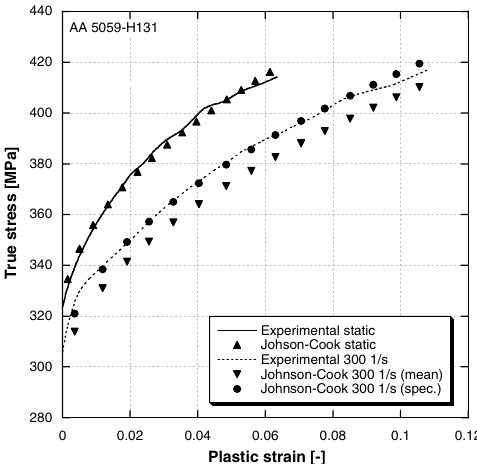
Fig. 13. Johnson-Cook fit for AA 5059-H131.